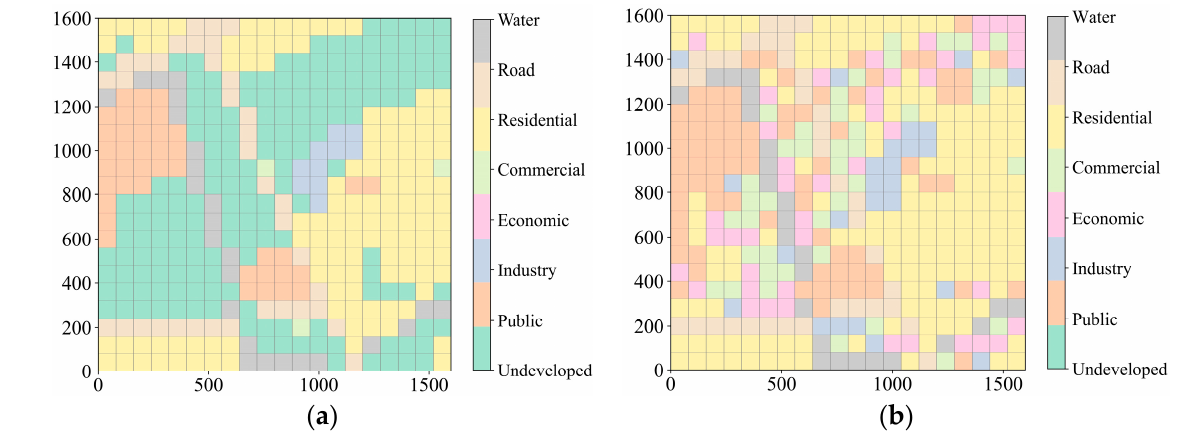
Figure 7. Land use sketch maps of initialization and optimization: ( a ) Initial land use maps of the station area; ( b ) Balanced optimized land use maps. Table 3. Performance of the extreme optimal solutions of the NSGA-III and EGA.